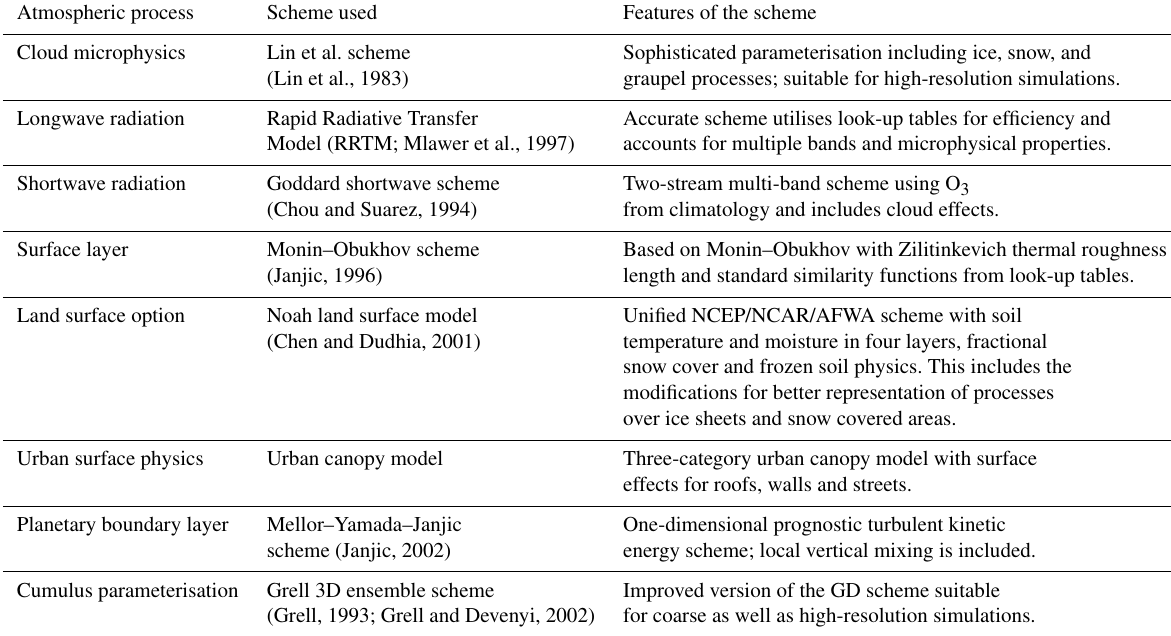
Table 1. The WRF-Chem options used for parameterisation of atmospheric